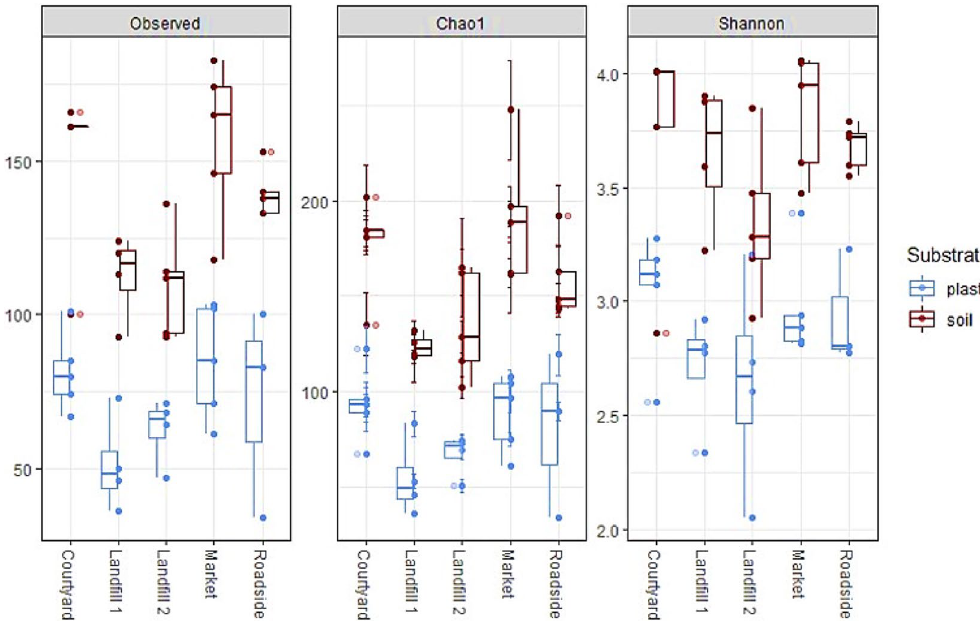
Figure 2. Alpha diversity metrics for the entire rarefied dataset according to substrates and sites. Samples were rarefied at the smallest library size (2496 sequences). Significance testing (ANOVA) revealed significantly higher fungal richness (observed, Chao1; both p < 0.01) and Shannon diversity (p < 0.01) of soil in comparison to plastic samples (Supplementary Fig. 2).